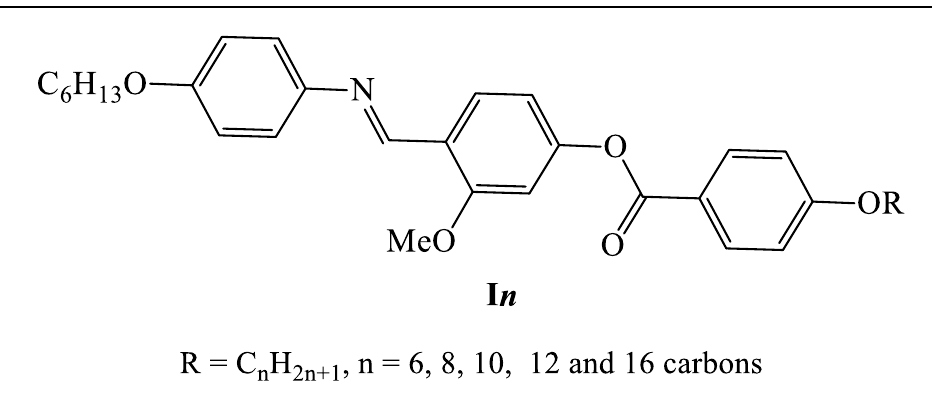
Figure 1. Chemical structure of 4-(4-(hexyloxyphenyl)iminomethyl)-3-methoxyphenyl 4-alkoxybenzoates, In .